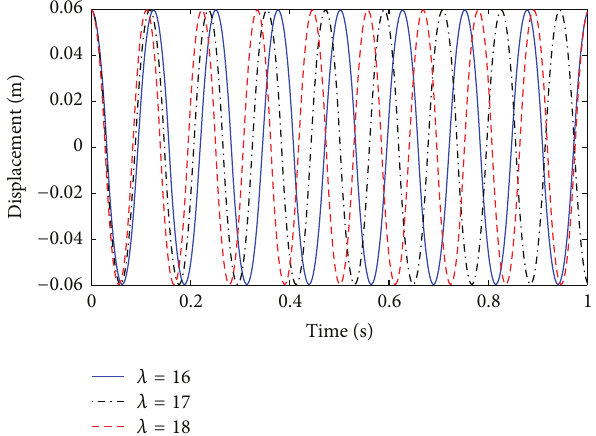
Figure 3: Vibrations in the vicinity of the boundary conditions without polygonal action at different 𝜆